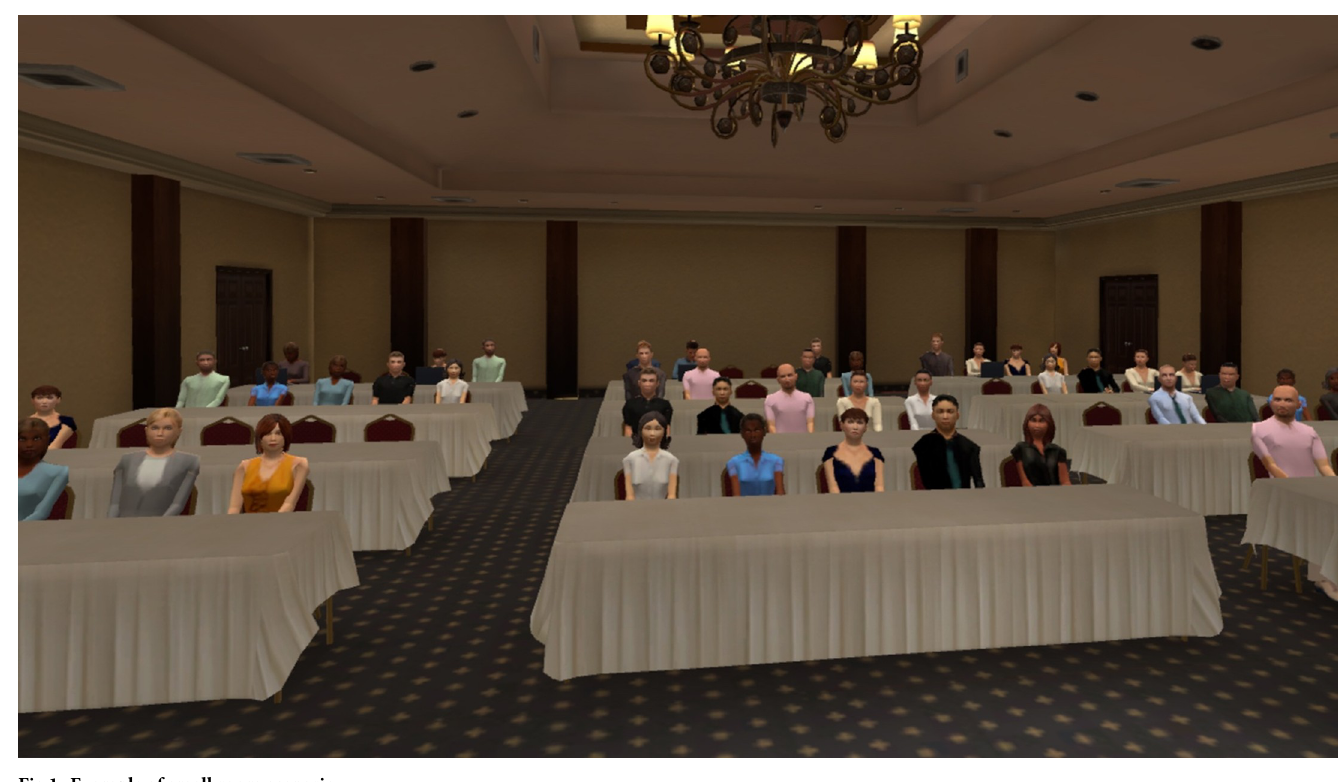
Fig 1. Example of small room scenario.